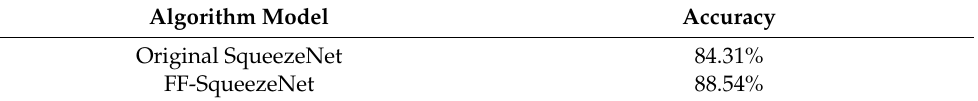
Table 3. Performance comparison of original SqueezeNet and our proposed